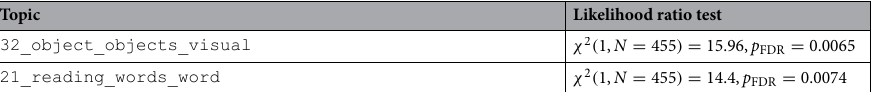
Table 1. Topics associated with studies reporting the VWFA and the frontoparietal attention network, but not reporting the ‘language’ network. We only depict associations surviving a likelihood ratio test and a false discovery rate (FDR) correction for multiple comparison ( p FDR < 0.05 ). More details on the likelihood ratio test are provided in the Supplementary Materials. Topics are those from Neurosynth’s v5-topics-100 topic 4 model. Out of Neurosynth’s 1.4371 × 10 studies, 455 report activations within the frontoparietal attention network without reporting activations within the ‘language’